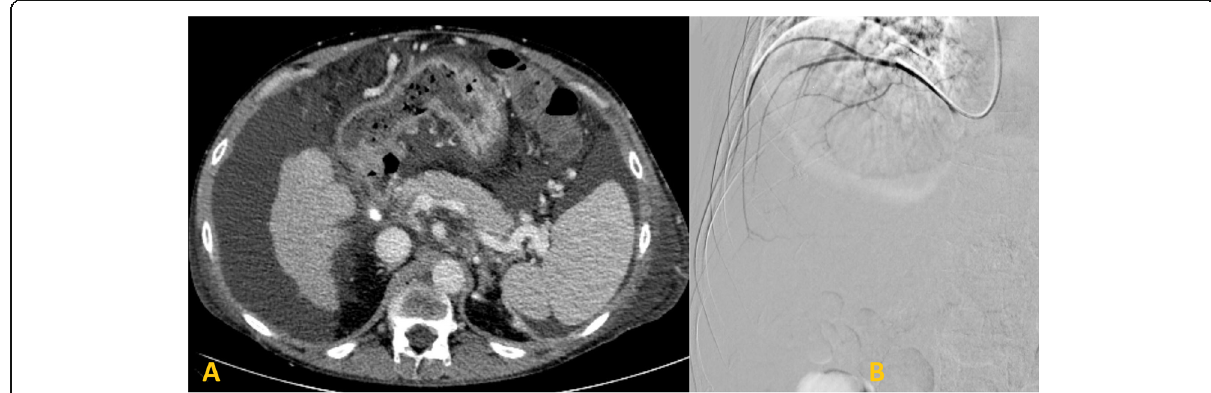
Fig. 1 a : CT abdomen with contrast demonstrating occlusion of the extra-hepatic PV with cirrhotic morphology of liver, ascites and gastric varices. b : Venogram demonstrating non-opacification of any hepatic veins. Only a right inferior phrenic vein was selected and